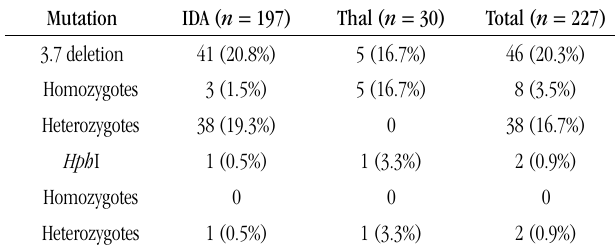
taBLE 1 − Frequency of 3.7 and Hph I mutations in individuals diagnosed with thalassemia minor and iron deficiency anemia